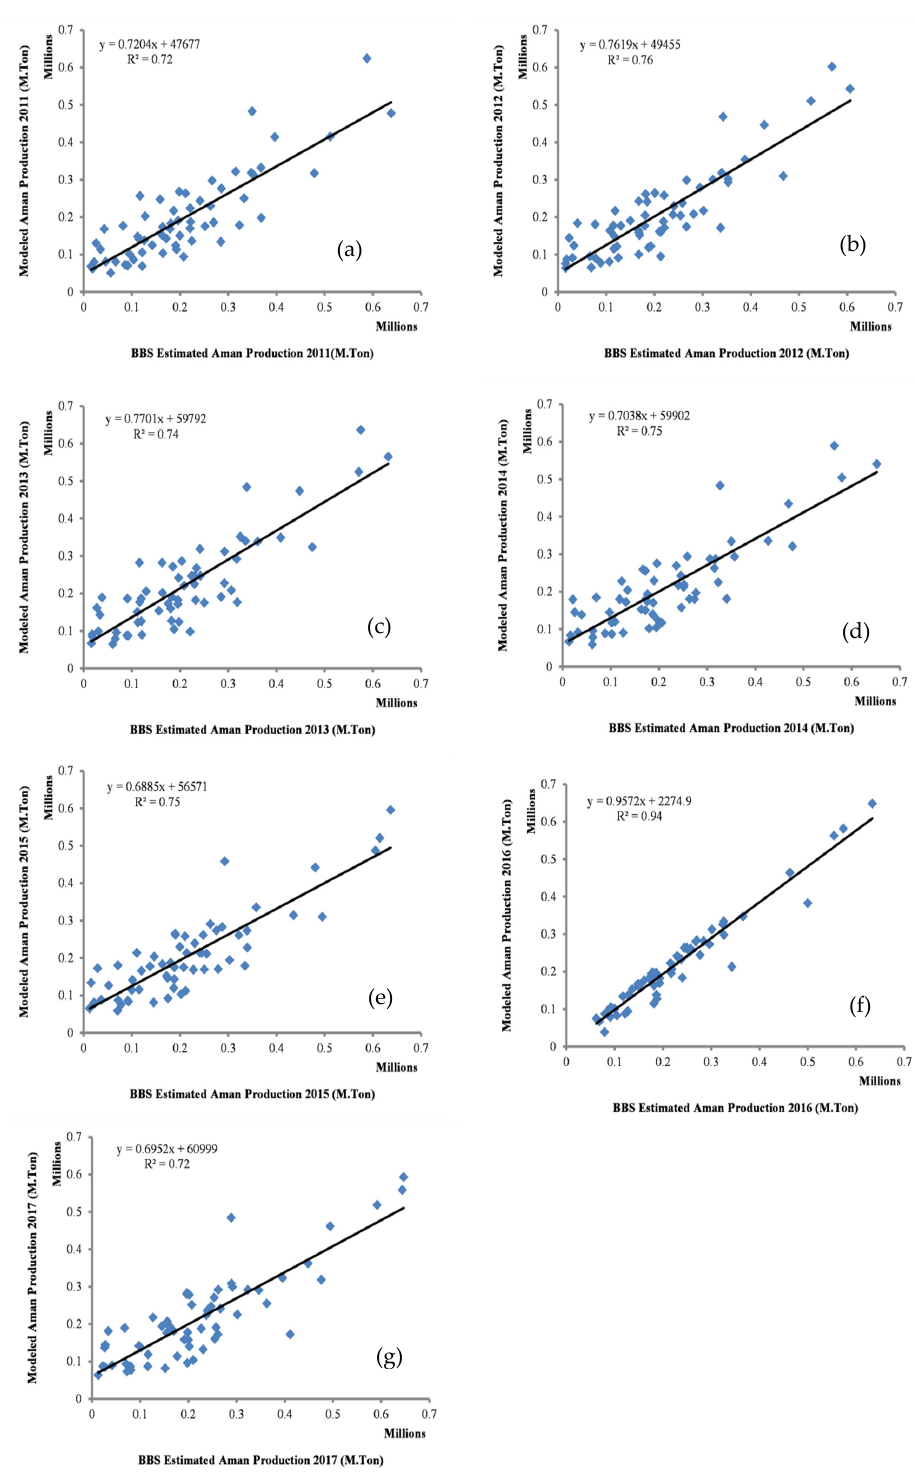
Figure 6. Correlation between RS model-based forecasted and ground-based (BBS estimated) production estimates at 61 district-levels during ( a ) 2011; ( b ) 2012; ( c ) 2013; ( d ) 2014; ( e ) 2015; ( f ) 2016; and, ( g ) 2017.